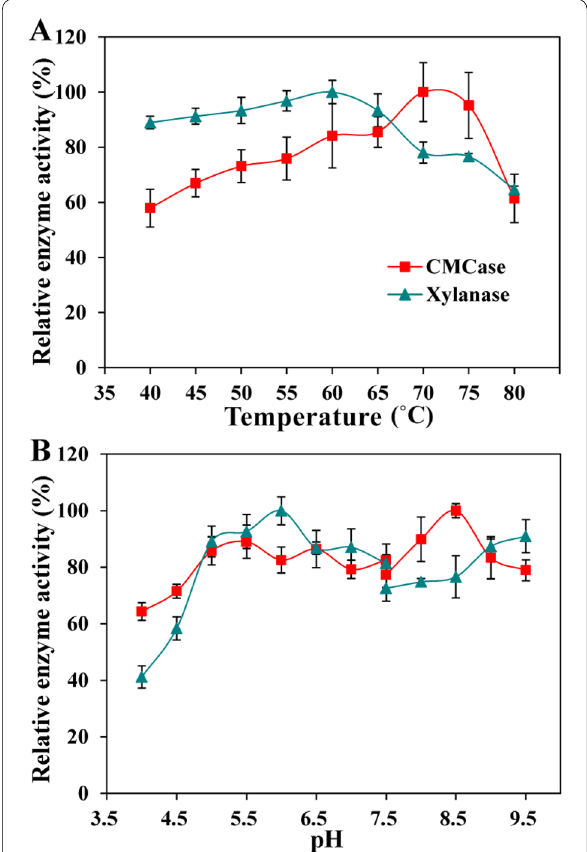
Fig. 4 Effects of different temperatures ( A ) and pH ( B ) on enzymatic activities (%) determined by incubating the crude enzymes with CMC or xylan for 30 min. Bars indicate the standard deviation ( n